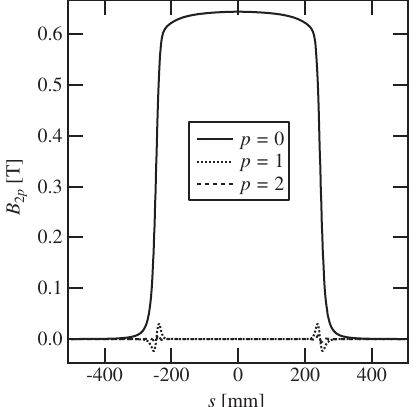
FIG. 15. Simulated field multipoles with quadrupole symmetry: